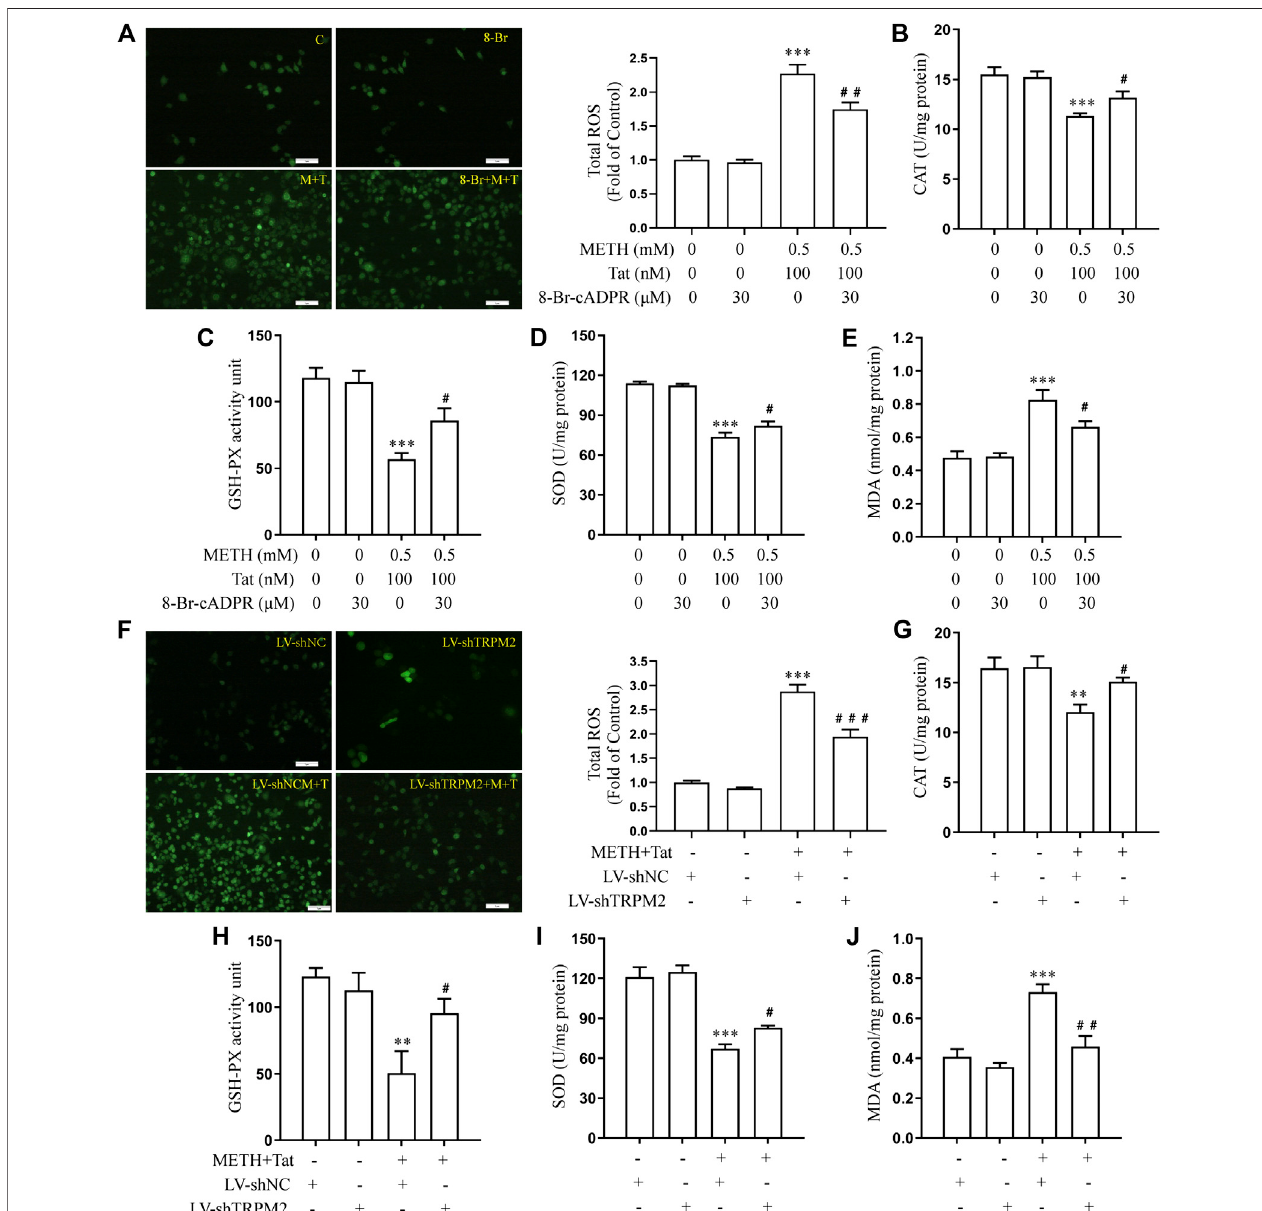
FIGURE 8 | 8-Br-cADPR and TRPM2 gene knockdown attenuate oxidative stress responses synergistically induced by METH and HIV-Tat. The hCMEC/D3 cells were transfected with LV-shTRPM2 or LV-shNC for 48 h or treated with or without 30 μ M of 8-Br-cADPR for 0.5 h before 0.5 mM of METH and 100 nM of HIV-Tat for 24 h. (A, F) ROS fl uorescence was observed via an inverted fl uorescence microscope (Scale bar: 1 µm), and fl uorescence intensity was analyzed using Image J software; (B – E, G – J) CAT, GSH-PX, and SOD activity and the level of MDA were measured using commercial kits. Compared with the control or LV-shNC, ** p < 0.01, *** p < 0.001; compared with the METH + HIV-Tat or LV-shNC + METH + HIV-Tat, # p < 0.05, ## p < 0.01, n (cid:1) 3. C (cid:1) Control, 8-Br (cid:1) 30 μ M of 8-Br-cADPR, M + T (cid:1) 0.5 mM of METH+100 nM of HIV-Tat, and 8-Br + M + T (cid:1) 30 μ M of 8-Br-cADPR+0.5 mM of METH+100 nM of HIV-Tat. LV-shNC (cid:1) empty vector, LV-shTRPM2 (cid:1) shTRPM2 lentivirus, LV-shNC + M+T (cid:1) empty vector+0.5 mM of METH+100 nM of HIV-Tat, and LV-shTRPM2+M+T (cid:1) shTRPM2 lentivirus+0.5 mM of METH+100 nM of HIV-Tat.